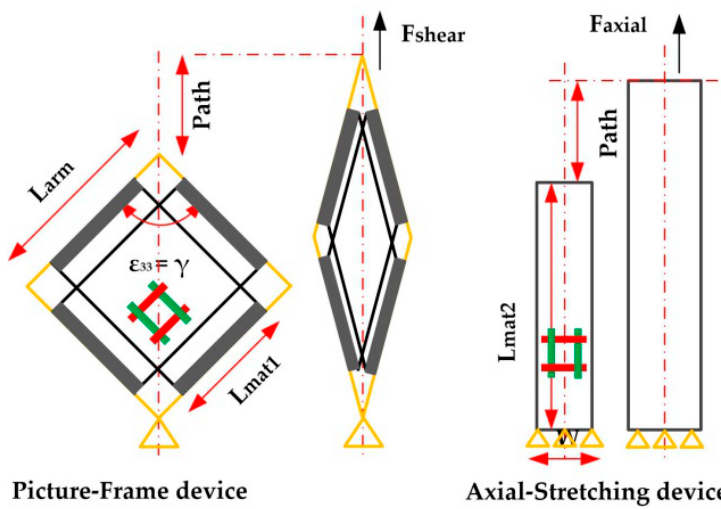
Figure 3. Schematic diagram of PF device and axial tensile device.